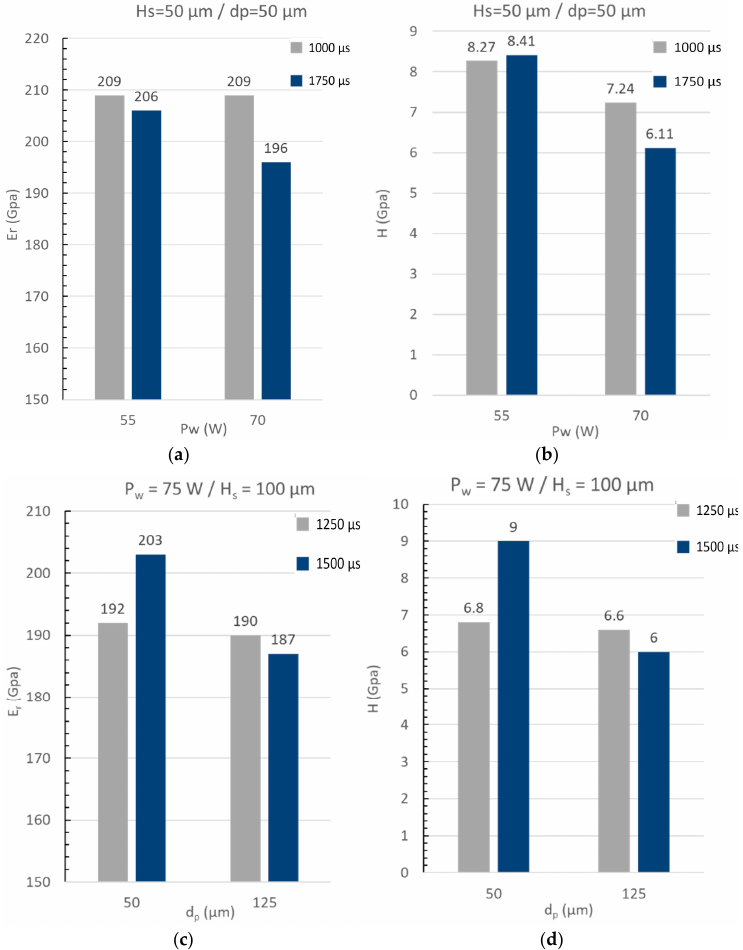
Figure 11. Graphs of hardness and reduced elastic modulus for different conditions of coatings. ( a ) Young modulus E r for H s = 100 µm and d p = 50 µm with two laser exposition time of 1000 µs and 1750 µs ; ( b ) Hardness H for H s = 100 µm and d p = 50 µm with two laser exposition time of 1000 µs and 1750 µs ; ( c ) Young modulus E r for P w = 75 W and H s = 100 µm with two laser exposition time of 1250 µs and 1500 µs ; ( d ) Hardness H for P w = 75 W and H s = 100 µm with two laser exposition time of 1250 µs and 1500 µs.